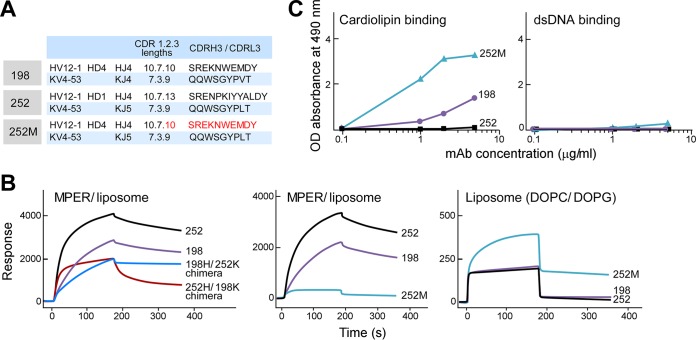
The CDRH3 loop plays a critical role in MPER specificity versus polyspecificity. (A) IgH and IgLk V(D)J gene usage of the related Abs 198 and 252. 252M is a 252 variant in which CDRH3 of clone 252 was replaced by CDRH3 of clone 198. (B) Relative binding affinities of chimeric rMAbs for MPER/liposomes compared to those of WT clones 198 and 252 as measured by SPR analysis (left), binding reactivities of 252M for MPER/liposomes in comparison to those of WT clones 198 and 252 (middle), and lipid-binding reactivities of clones 198, 252, and 252M (right). (C) rMAbs were tested for polyreactivity by cardiolipin and dsDNA ELISAs.